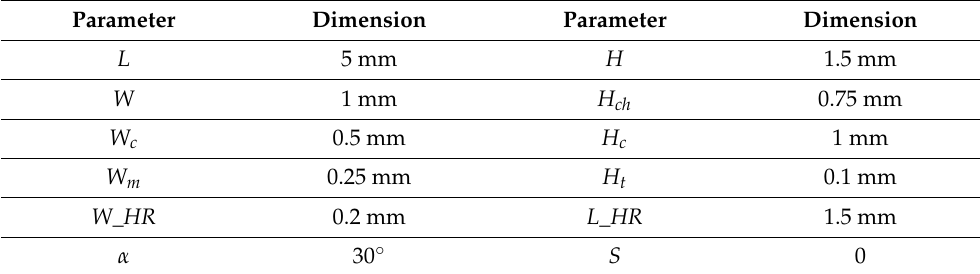
Table 1. The size parameters of the marked position on the three views in Figure 3. Parameter Dimension